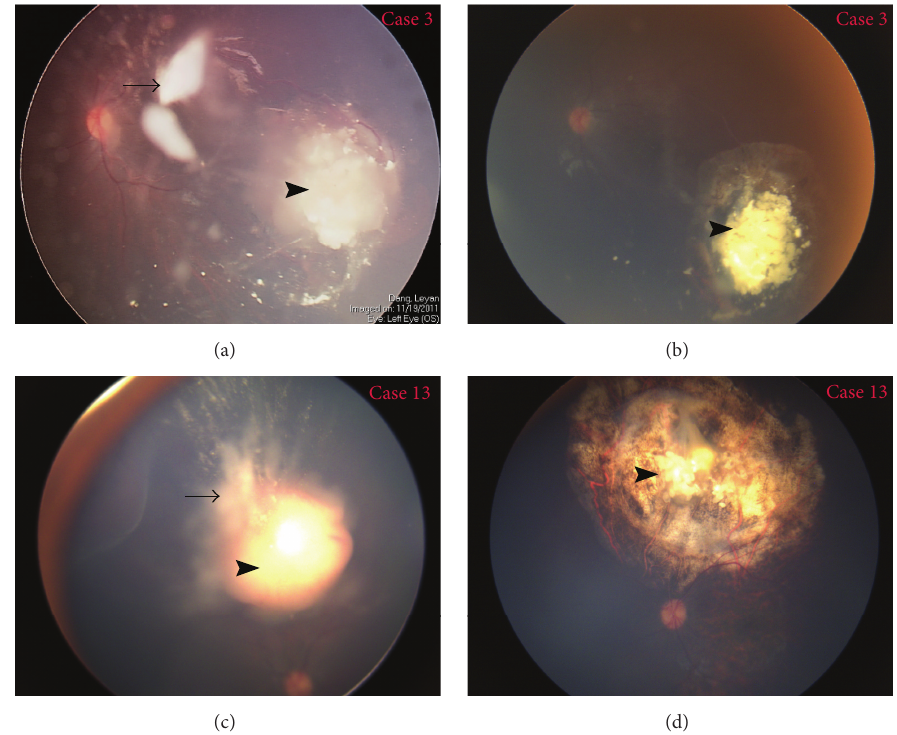
Figure 1: Control of resistant seeds in case 3 (upper) and case 13 (lower). (a) and (c) Vitreous seeds (arrow) and tumor (arrow head) were still active after 4 cycles of IVC and focal consolidation in case 3 and 4 cycles of IVC and 2 cycles of OAC in case 13. (b) After 11 cycles of intravitreal melphalan, 2 additional IVC, and focal consolidation, vitreous seeds regressed into type 1 and tumor (arrow head) shrank and completely calcified. (d) After 4 cycles of intravitreal melphalan, one additional OAC, and focal consolidation, vitreous seeds regressed into type 0 and tumor (arrow head) shrank and completely